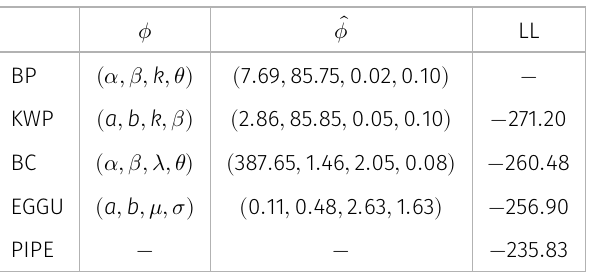
Table II. Estimation for the Wheaton river data